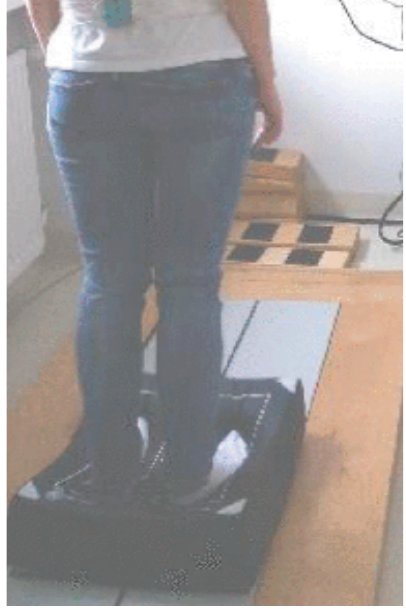
Figure 1. The posture in the posturographic test.